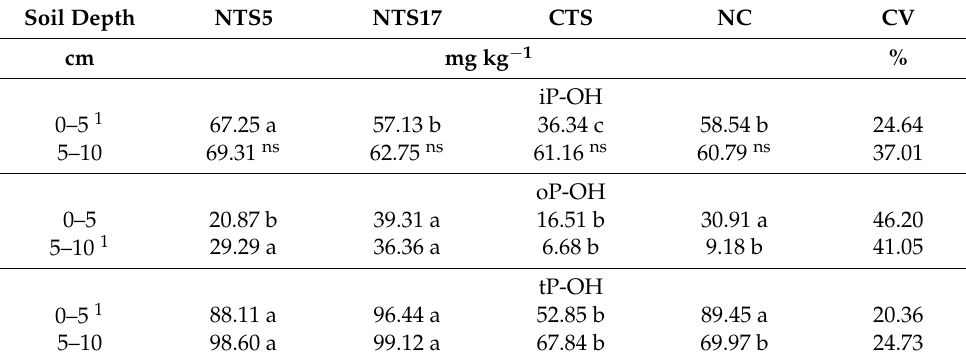
Table 6. Moderately resistant portion of inorganic P (iP-OH), organic (oP-OH), and total (tP-OH) from the soil extracted in sulfuric acid solution (H 2 SO 4 ) in the different management